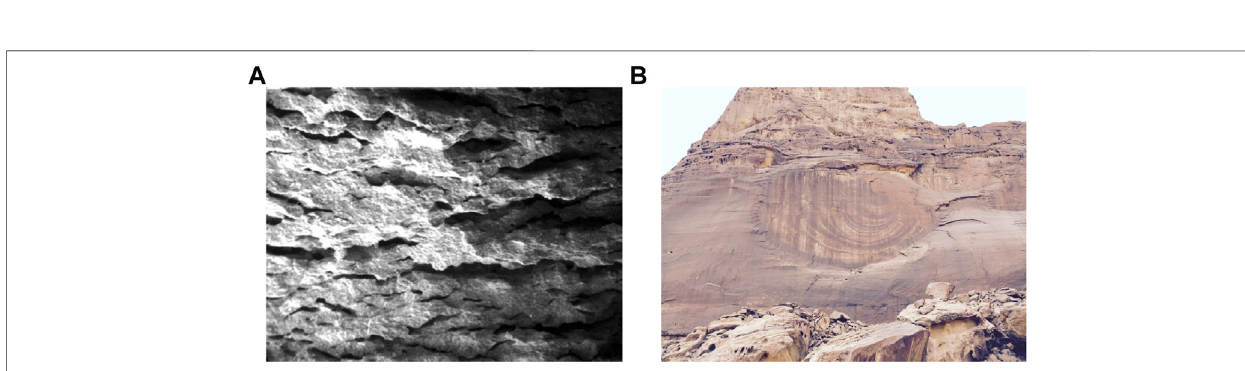
FIGURE 15 | Thermo-hydro fractures. (A) Extensively fractured kaolinite paste after heating in microwave oven (scale = 1 mm). (B) Natural thermo-hydro fracture (scale = 25 m – Madain Saleh, Saudi Arabia).